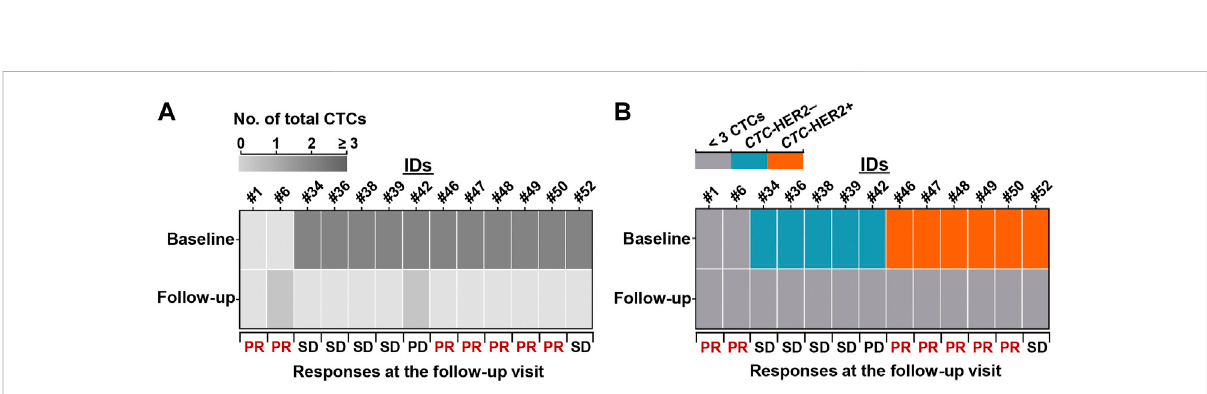
FIGURE 5 Reduction of CTC number and pretherapeutic CTC -HER2+ might predict patient ’ s bene fi t from anti-HER2 treatment. (A,B) Heatmaps of dynamic changes of totalCTC count (A) and CTC -HER2 phenotype (B) from baselineto follow-upvisit. 13 HER2+ patients with second blood draws and clinical responses at the follow-up visit were